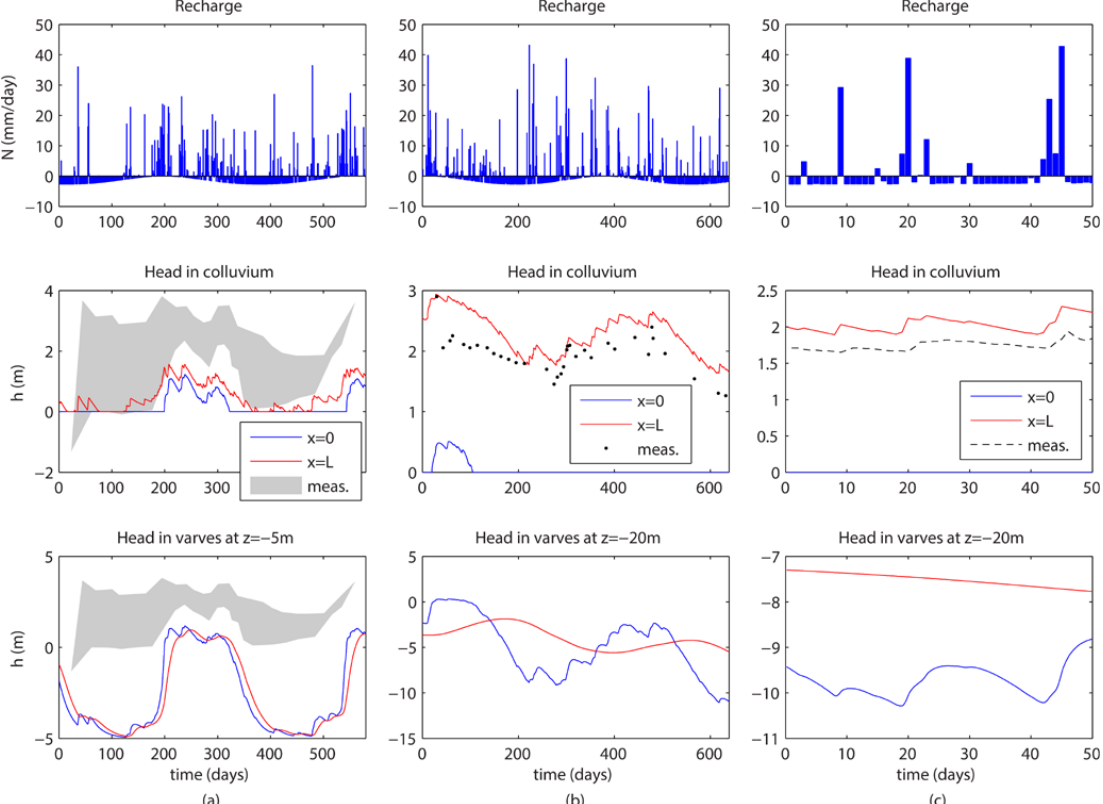
Fig. 6. Recharge (first row), measured and simulated heads for the colluvium (second row) and varved clays (third row) for the Avignonet landslide during three monitoring periods. (a) July 1985–January 1987, (b) January 2004–September 2005, (c) July 2008–September 2008 . Head variations are shown with respect to the bottom of the colluvium/top of the varved